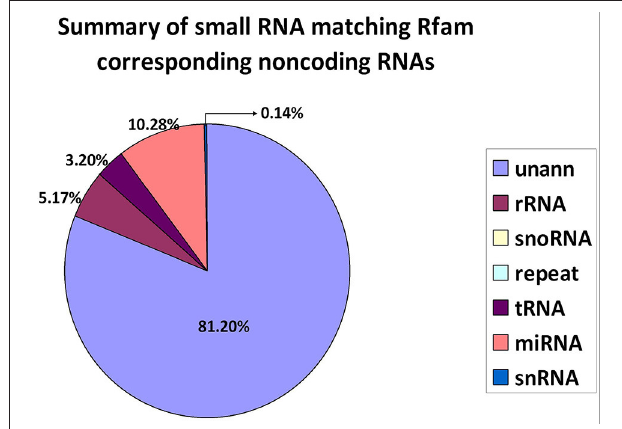
FIGURE 2 | Distribution of small RNAs among different categories. Unann, unannotated; rRNA, ribosomal RNA; snoRNA, small nucleolar RNA; tRNA, transfer RNA; miRNA, microRNA; and snRNA, small nuclear RNA.